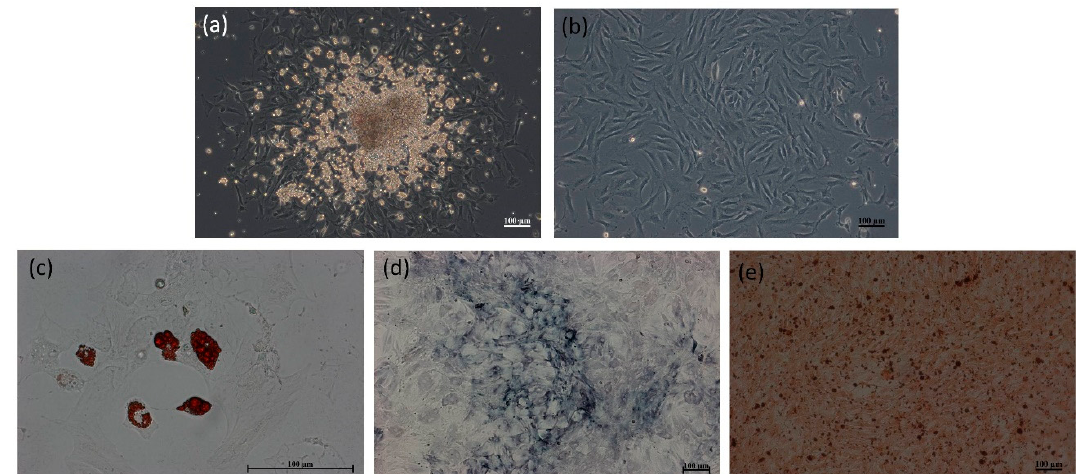
Figure 2. The optical images of rat bone marrow stromal cells (MSCs) at passsage-1 ( a ) and passsage-4 ( b ). Differentiation of rat MSCs into adipocytes and osteoblasts. Adipogenic MSC formed phase-bright vacuoles and were stained with oil red O ( c ). ALP staining ( d ) and Alizarin Red S staining ( e ) of osteogenic rat MSCs. Scale bar = 100 μ m.